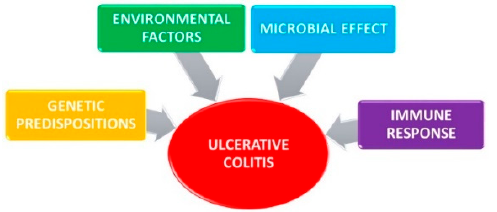
Figure 2. Main factors for the development of ulcerative colitis.